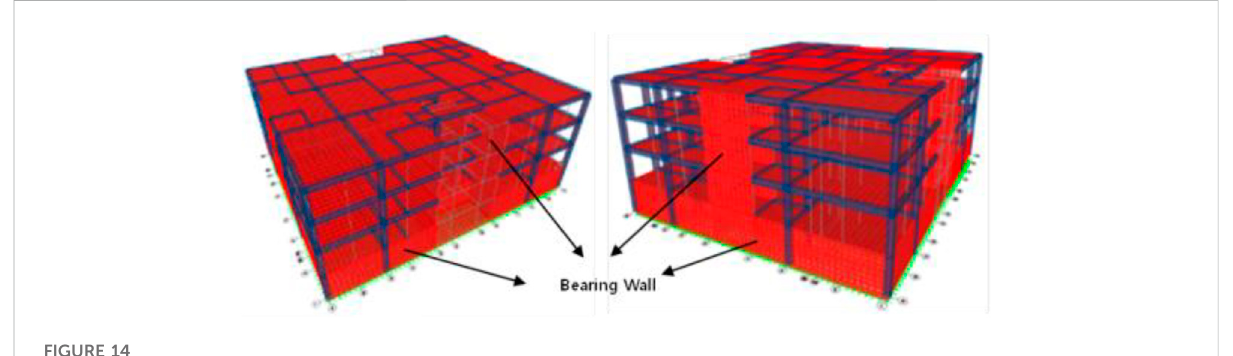
FIGURE 14 3D model of a library building: (A) right view and (B) left